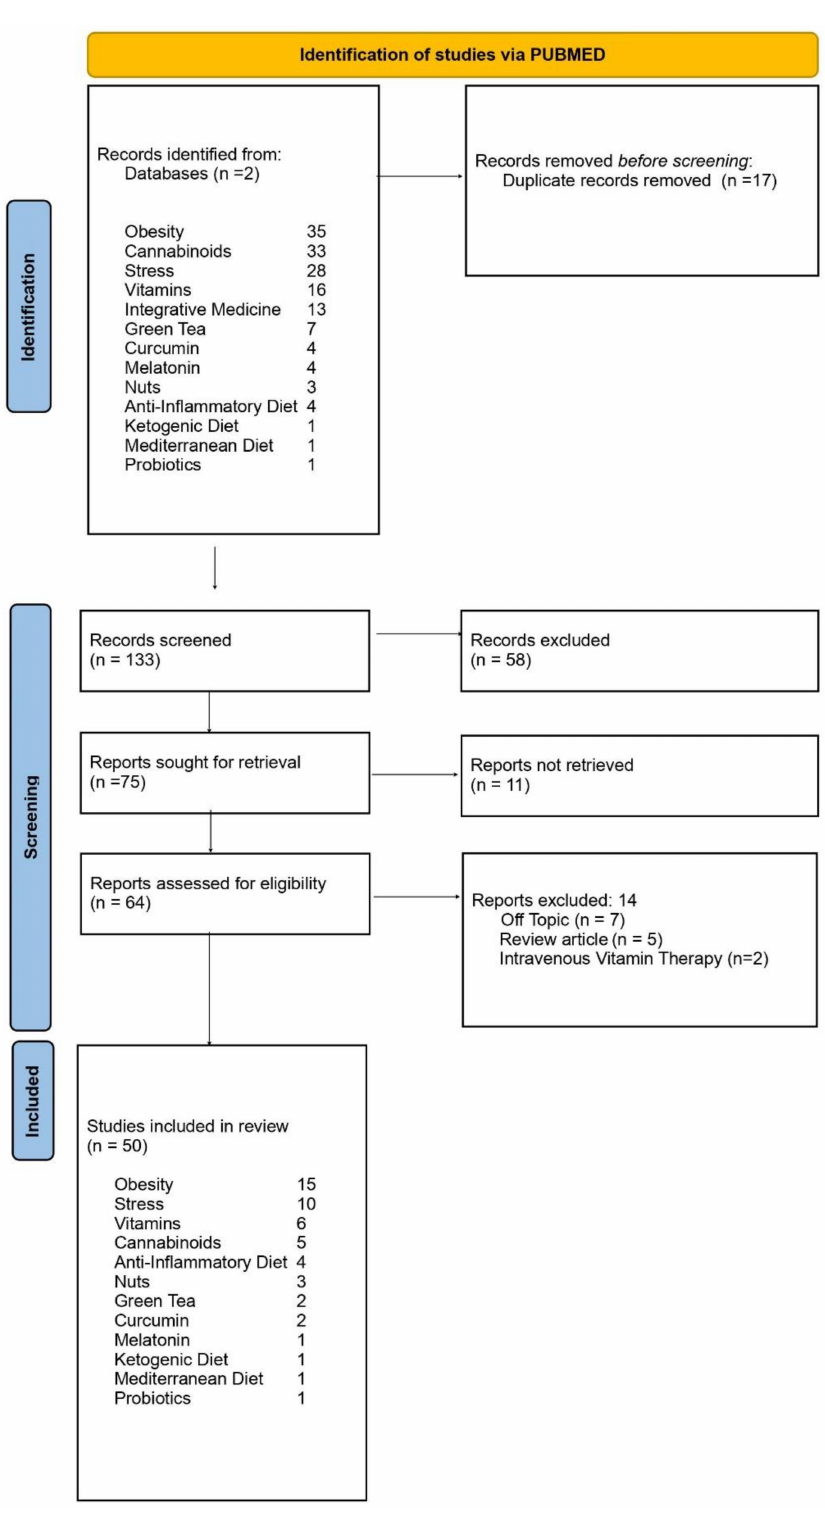
Figure 1. PRISMA 2020 flow diagram for systematic review of Integrative Medicine recommendations for patients with pancreatic cancer which included searches of PUBMED